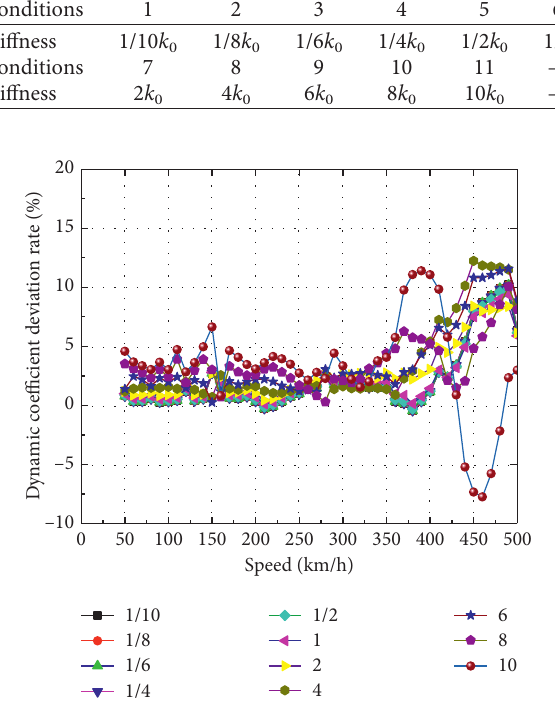
Figure 19: Dynamic coefficient deviation rate of the bridge under the spring-damping-mass